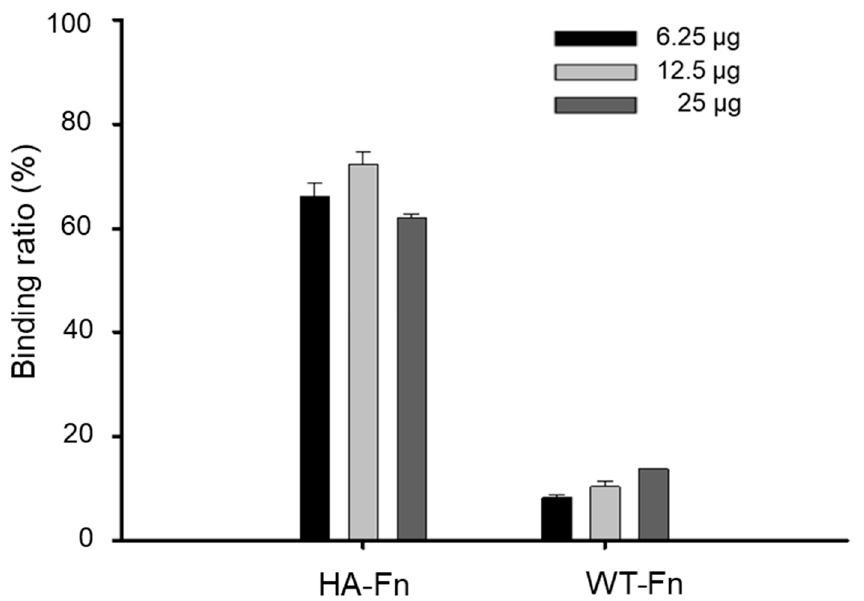
Figure 3. Binding of ferritin nanoparticles on hydroxyapatite resin. Cy5-labeled ferritin nanoparticles were incubated with the hydroxyapatite resins at various concentrations for 1 h. The binding ratio was defined as the fluorescent signal from resin compared with the initial fluorescent signal. Data are represented as the mean ± standard deviation ( n = 3).